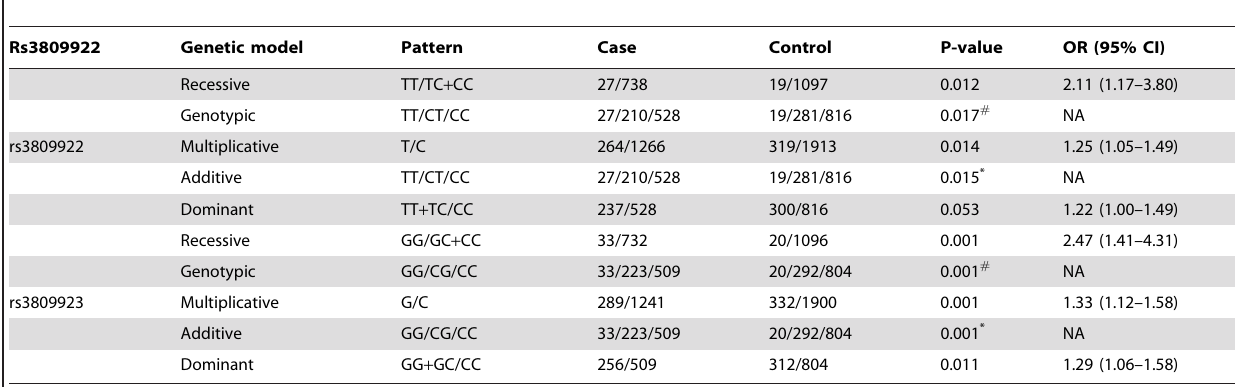
Table 4. Association of rs3809922 and rs3809923 variants with septation